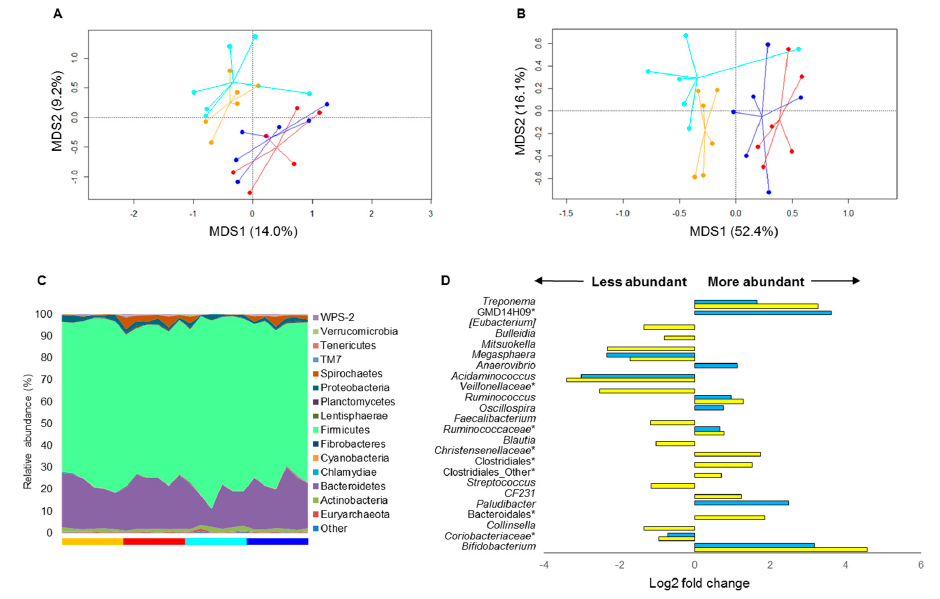
Figure 2. Modulation of the swine fecal microbiota after einkorn vs. wheat bread-based intervention. Principal Coordinate Analysis (PCoA) of unweighted ( A ) and weighted ( B ) UniFrac distances between the microbial profiles of pigs before and after 30-day consumption of einkorn (cyan, t0; blue, t30) or wheat bread (orange, t0; red, t30). A significant separation between t0 and t30 samples was found for both groups, according to both metrics ( p value ≤ 0.003, permutation test with pseudo-F ratios). ( C ) Relative abundance of phylum-level taxa in the fecal microbiota of einkorn vs. wheat bread-fed pigs. Bars below the area chart are colored according to the diet group and time point, as in ( A ). ( D ) Genus-level signatures of response to nutritional interventions, shown as Log2 fold changes between t30 and t0 samples for the einkorn (light blue) or wheat (yellow) bread group. *, unclassified Operational Taxonomic Units (OTUs) reported at higher taxonomic level. p value < 0.05, Wilcoxon